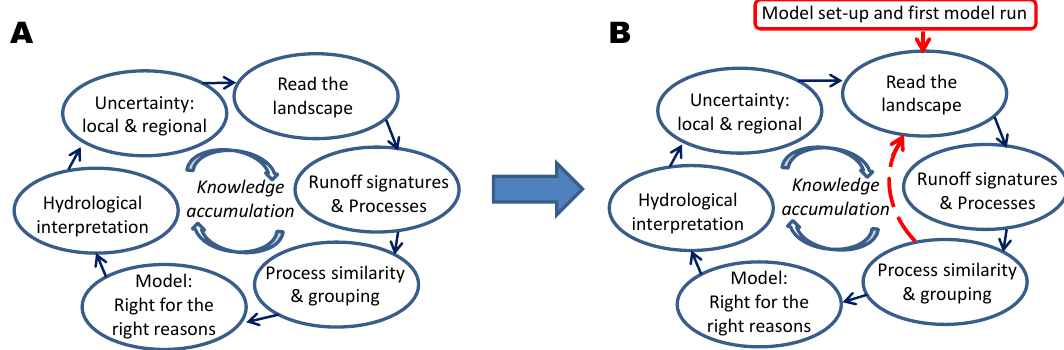
Figure 1. Best practices for predictions in ungauged basins: (a) according to Fig. 13.1 by Takeuchi et al. (2013) in Blöschl et al. (2013); (b) modified version for multi-basin applications at the large